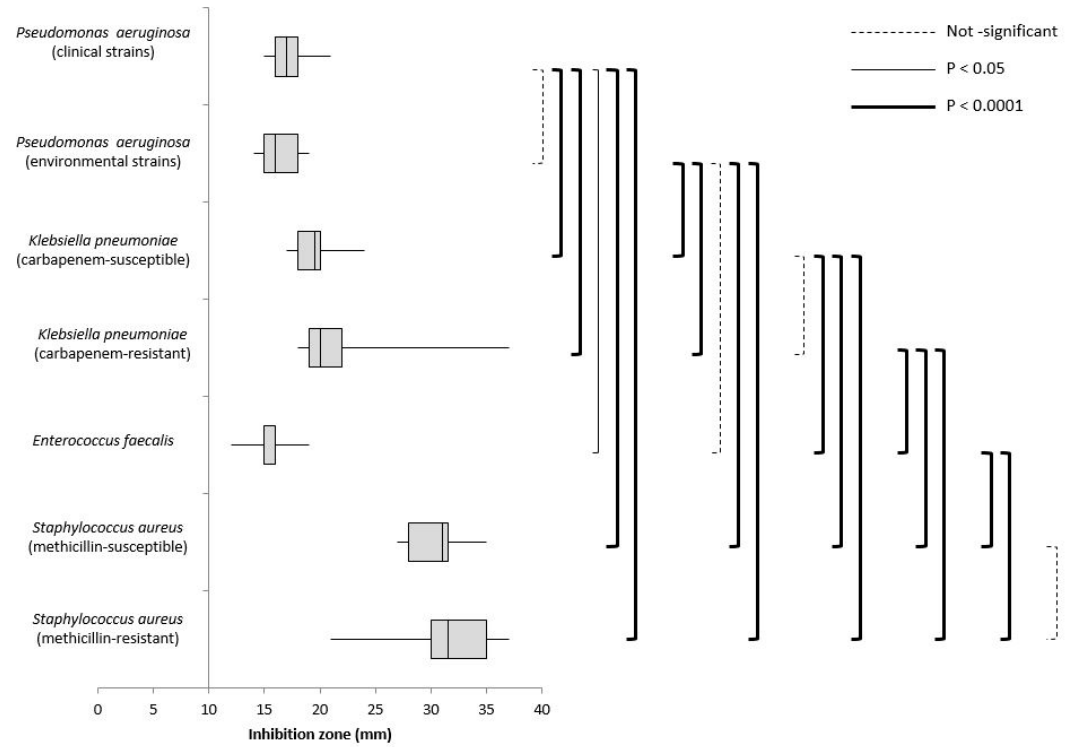
Figure 1. Box plot of the hydrogen peroxide effect. Pairwise multiple comparisons between different bacterial strains are shown.